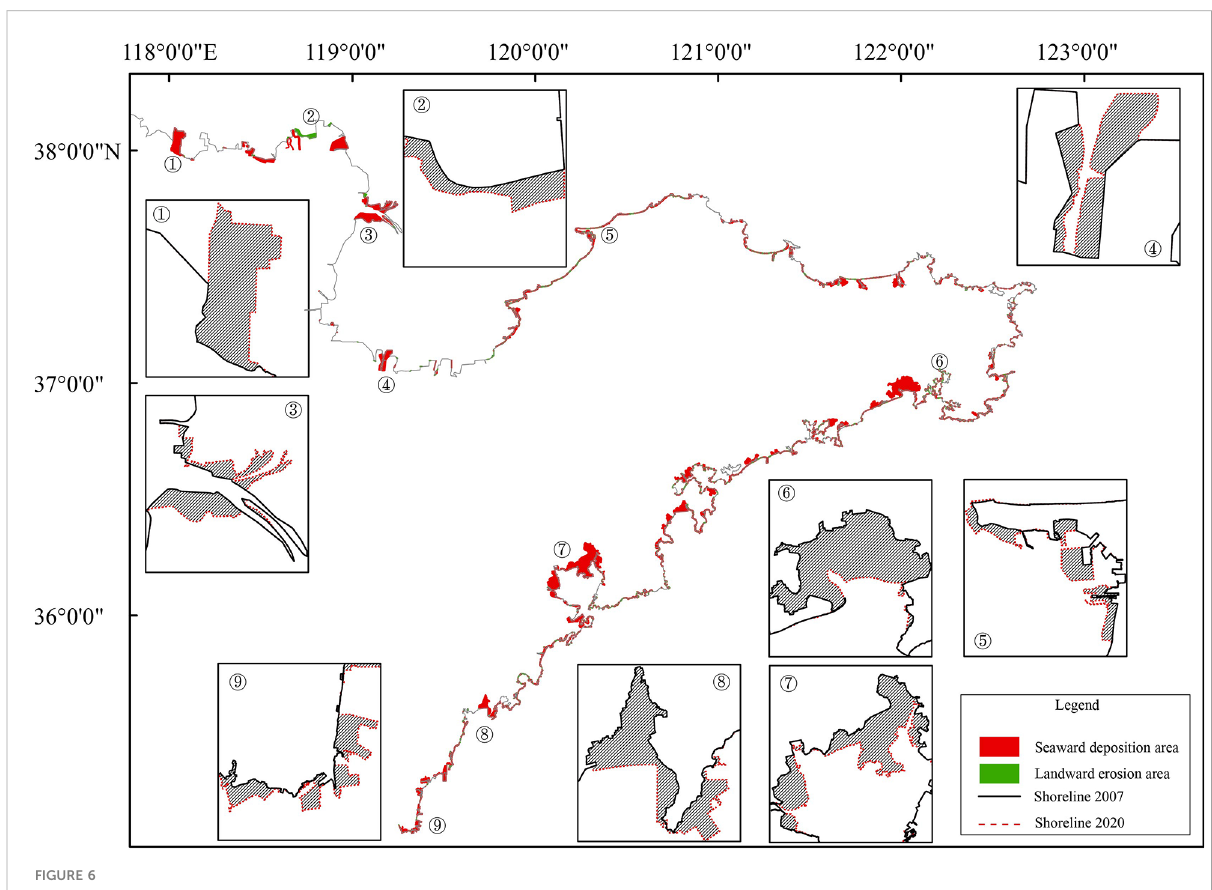
FIGURE 6 Land area changes in the Shandong Peninsula from 2007 to